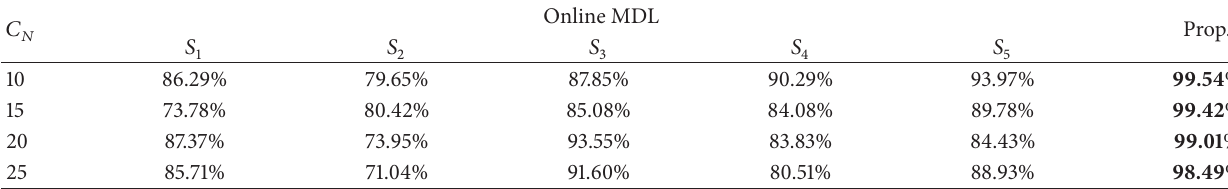
Table 1: Classification accuracy of 5 sensors.